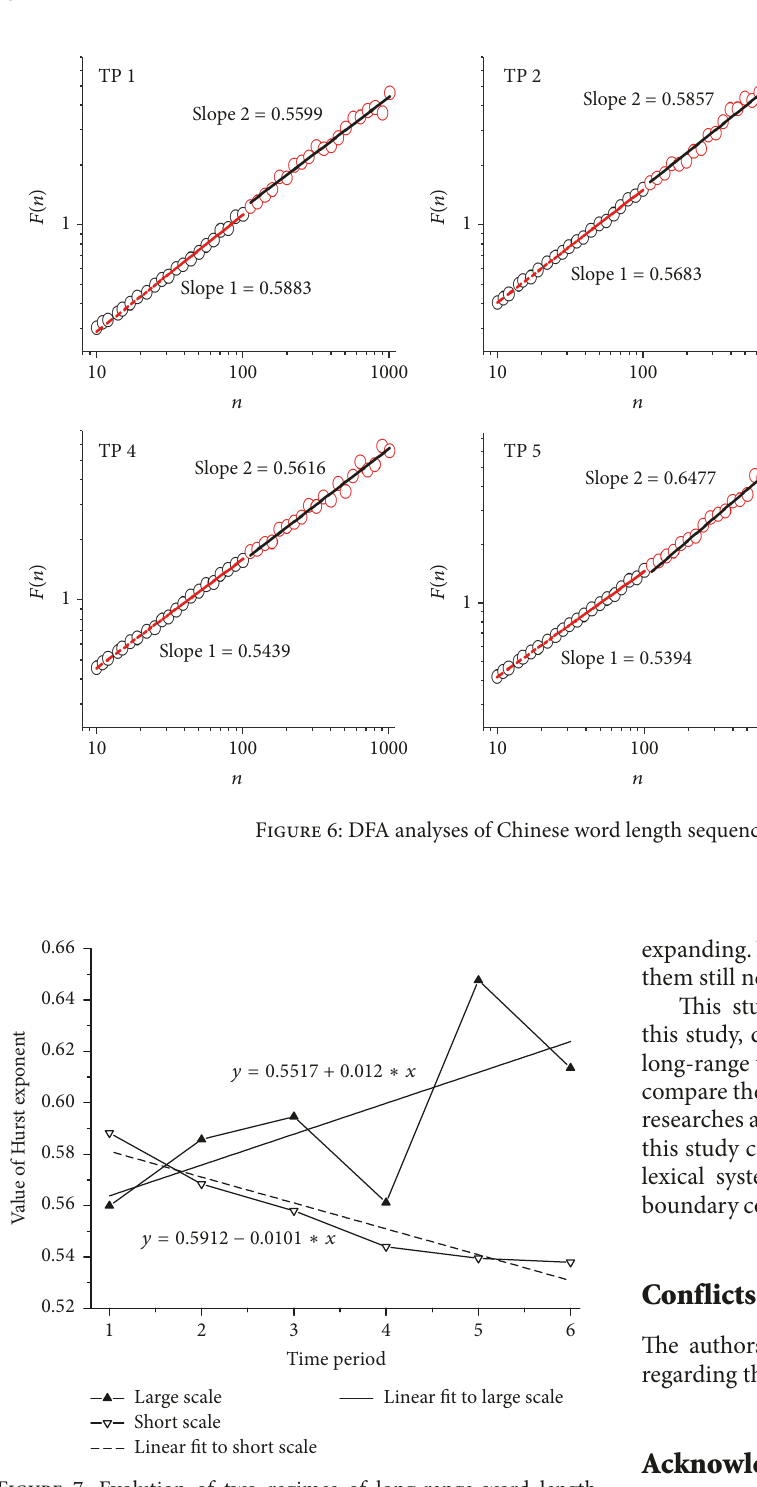
Figure 7: Evolution of two regimes of long-range word length correlations in written